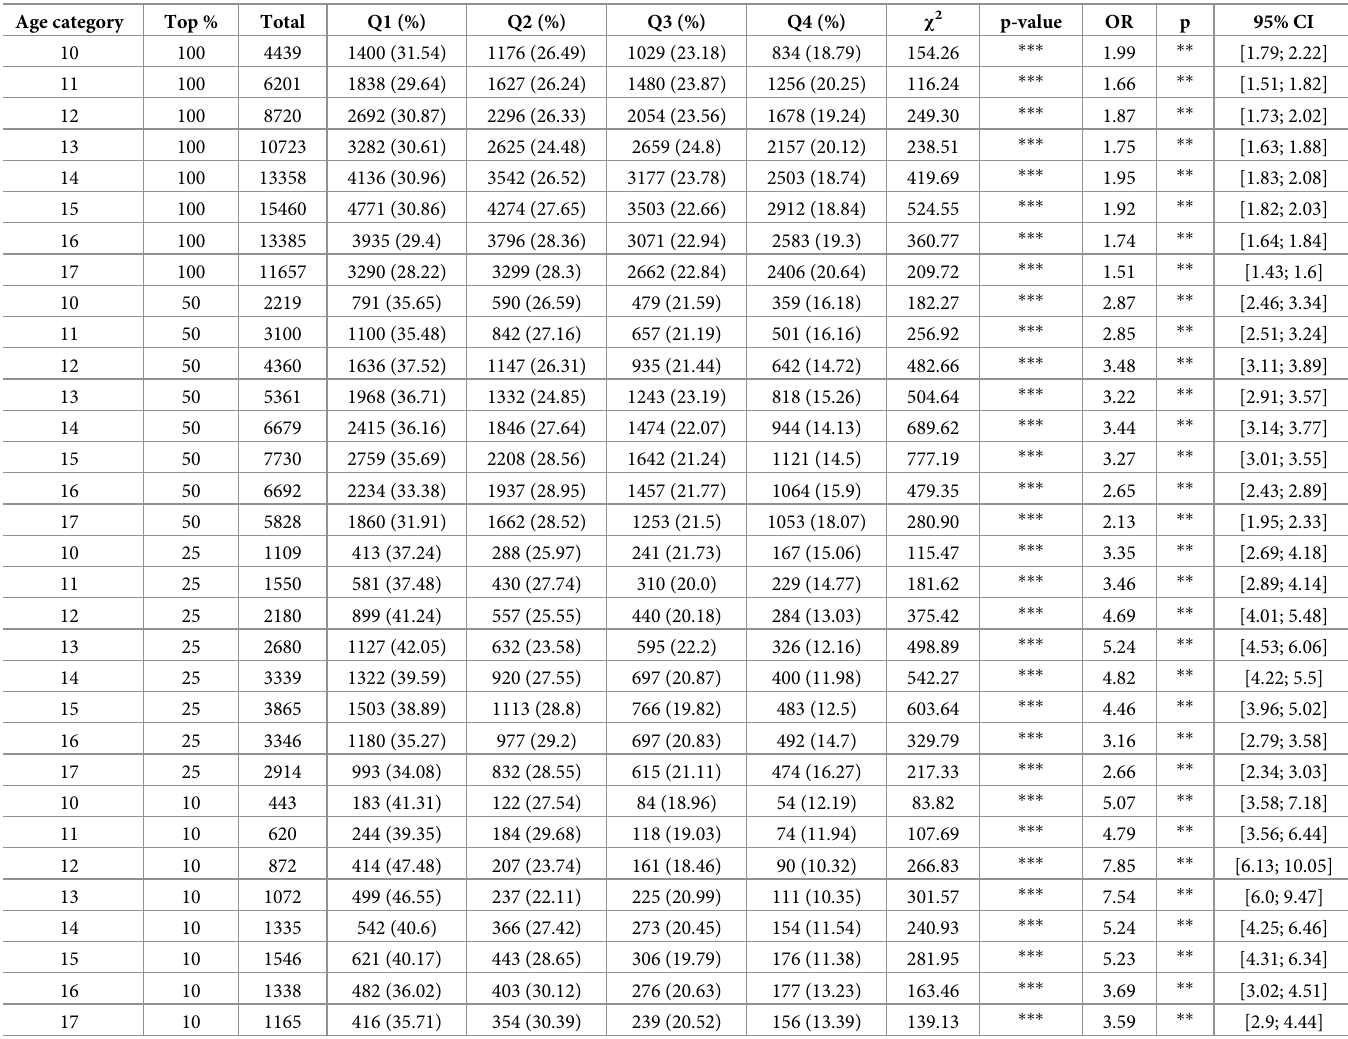
Table 1. Birth quarters distribution according to age and level of competitiveness of 50m Freestyle male swimmers in 50m pool.